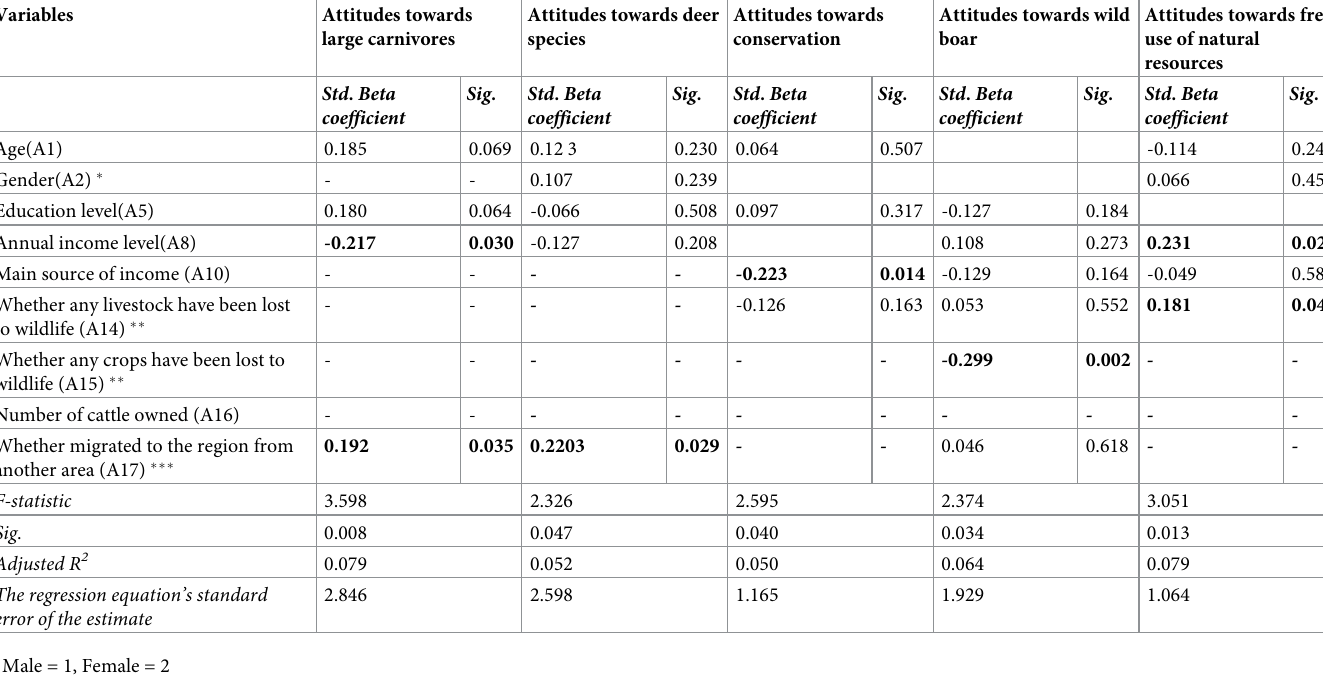
Table 3. Important variables associated with the attitude towards wildlife using multiple linear regressions (n = 120). A regression model with nine potential influ- encing variables was run for each of the five attitude factors to determine their values. The F value and variable numbers were taken into consideration when selecting the result. Results in bold font represent highly significant